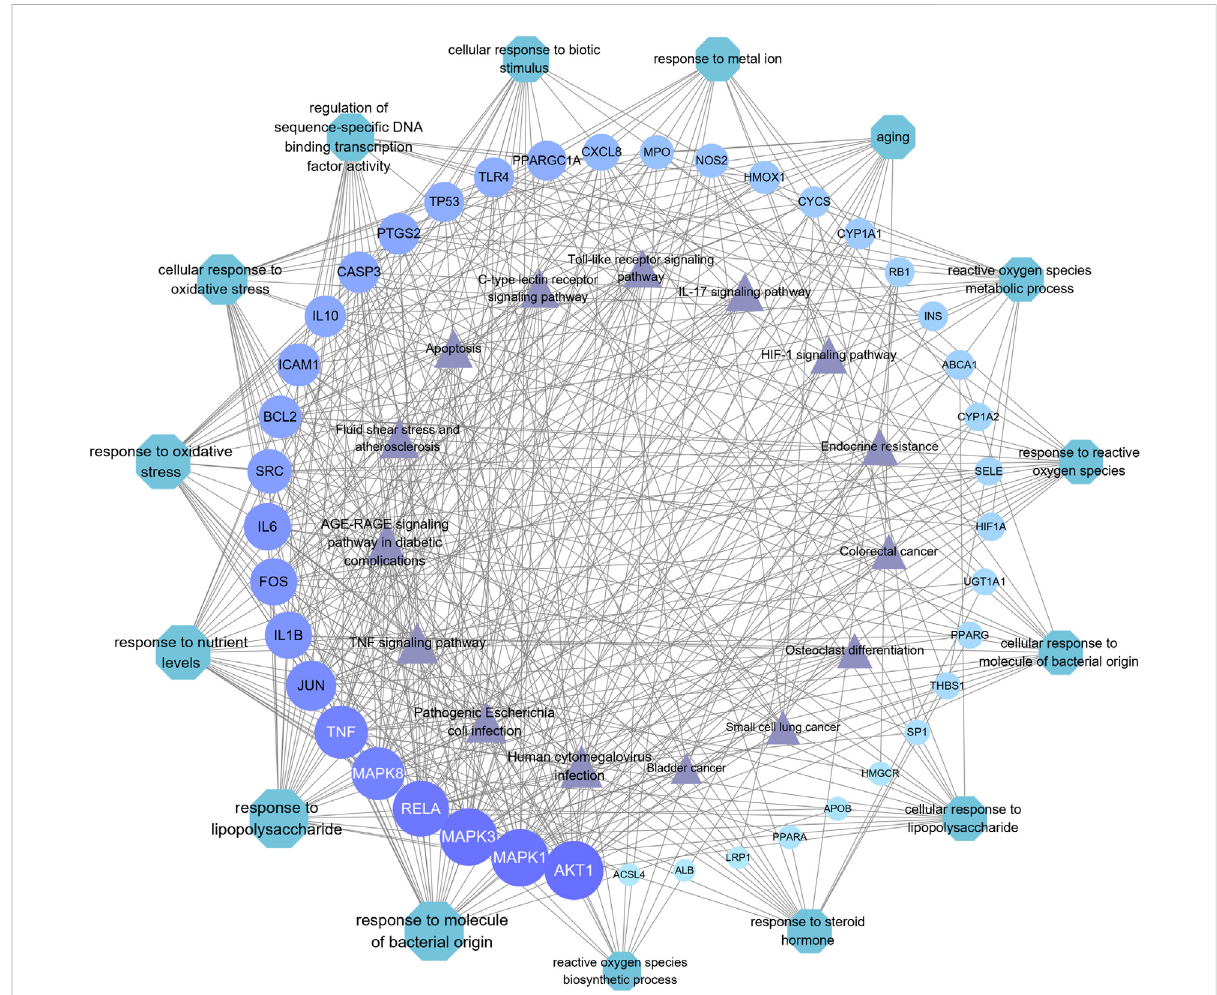
FIGURE 7 Correlationbetweencoretargetgenes,thetop15biologicalfunctioncatalogs,andthetop15signalingpathways.Thesizeofeachnodeandthe color depth in the network represent the size of its degree. Each node is interconnected by the gray connection